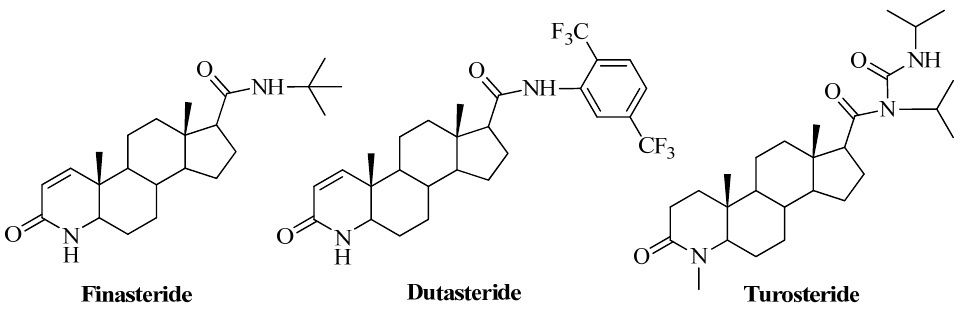
Figure 1. Representative 5 α -reductase